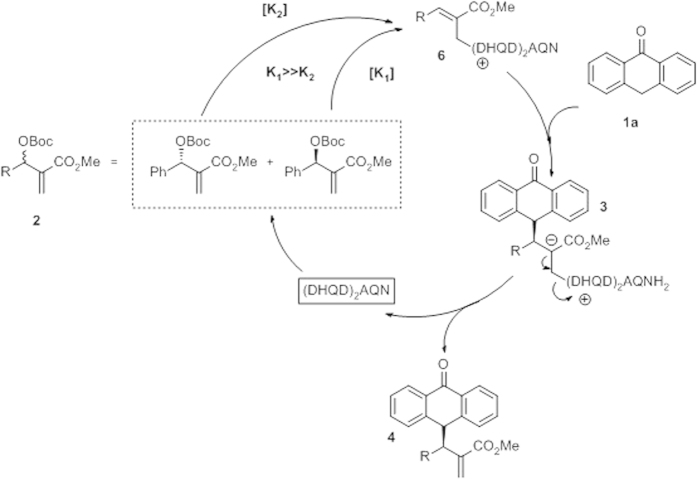
Proposed mechanism.